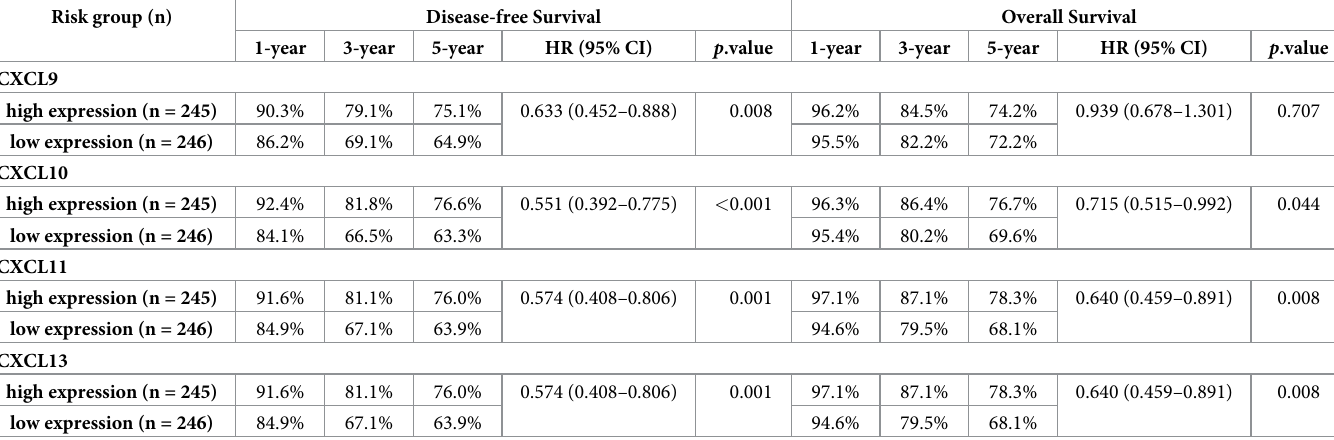
Table 3. Log-rank test of disease-free survival and overall survival according to CXCL9, CXCL10, CXCL11, and CXCL13 expression in dataset GSE39582 (n = 491).